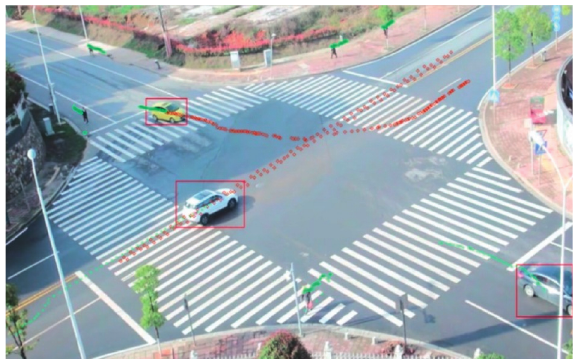
Figure 23: Real-time vehicle trajectory prediction